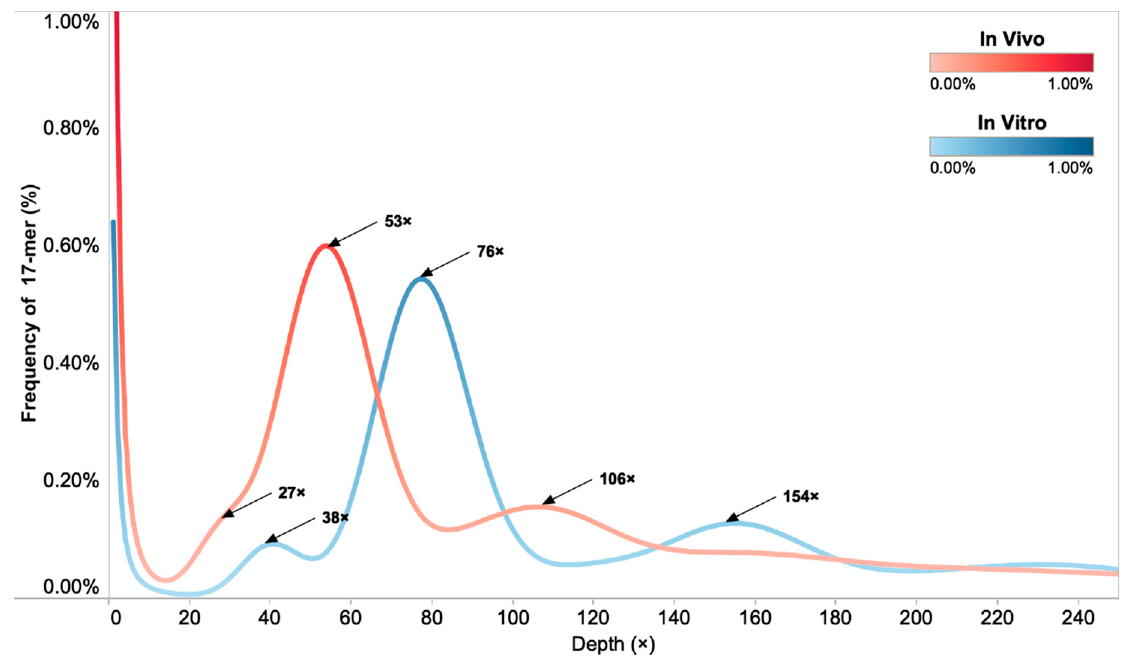
Figure 4. Distribution of 17-mer depth and frequency of in vivo (red line) and in vitro (blue line) M. cordata . The highest cut-off frequency is at 1% and the maximum cut-off depth is at 250×. Arrows indicate the half depth, the depth, and the double depth of the main peak, respectively. The main peak represents the overall sequencing depth of the genome. The second-highest peak around the double depth of the main peak represents repetitive sequences. The nonobvious peak at the half depth of the main peak represents the heterozygous peak. The 17-mer distribution suggests that the genome of M. cordata is highly repetitive.